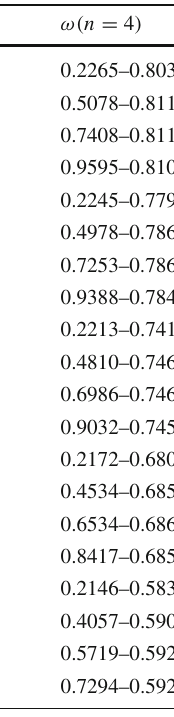
Table 3 Quasinormal frequencies of gravitational perturbation of regular Bardeen black hole surrounded by quintessence for β = 0 . 5 and c = 0 .